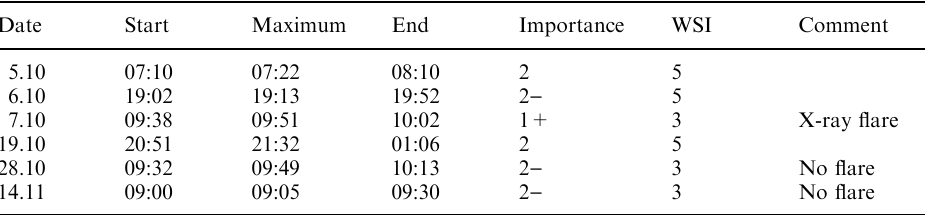
Table 4. List of important SIDs in October–November 1997. WSI, widespread index (maximum 5), importance indicates importance of SID (maximum